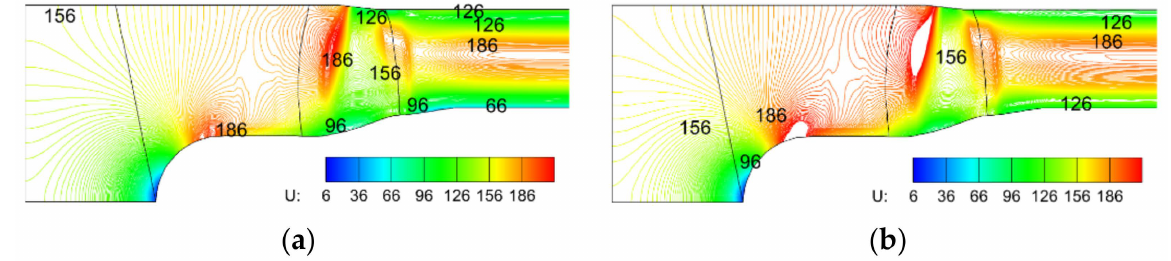
Figure 24. Isoline of the axial velocity for 11D: ( a ) distorted; ( b ) clean.